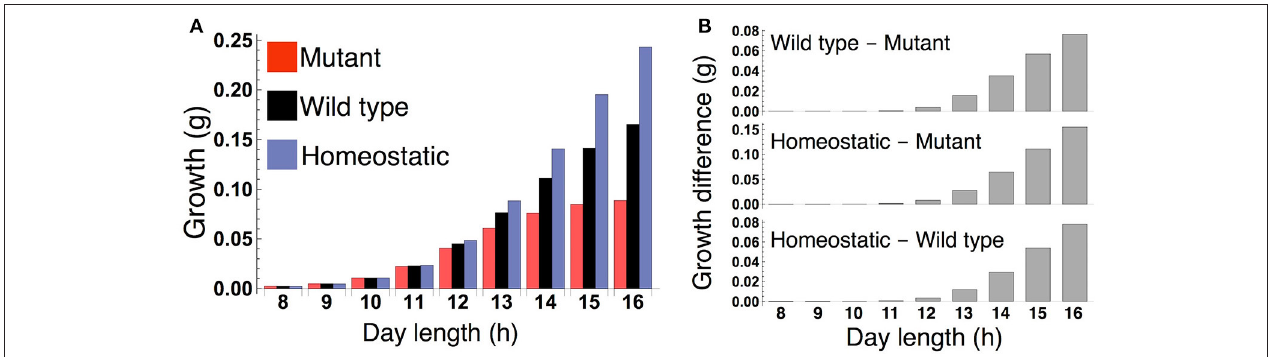
FIGURE 3 | (A) Growth of the sink (SAM or RAM) of the mutant, wild type, and homeostatic plant over 10 days under constant photoperiod conditions. (B) Growth difference between the wild type and mutant (upper), between the homeostatic and mutant (middle), and between the homeostatic and wild type (lower).